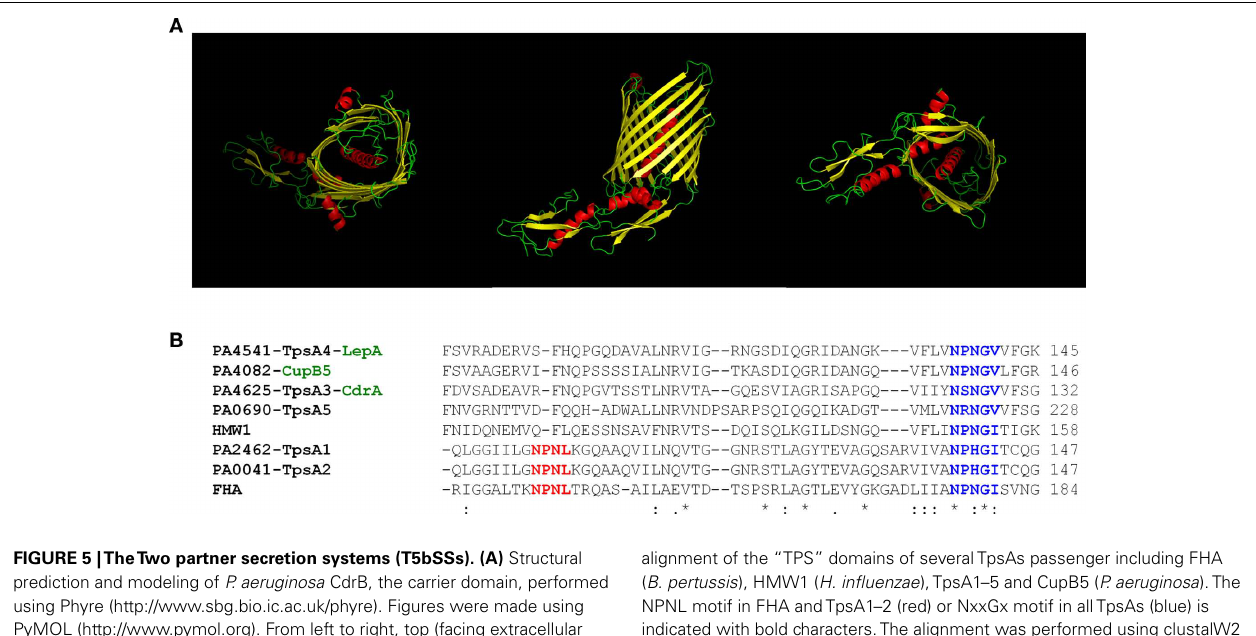
FIGURE 5 |TheTwo partner secretion systems (T5bSSs). (A) Structural prediction and modeling of P. aeruginosa CdrB, the carrier domain, performed using Phyre (http://www.sbg.bio.ic.ac.uk/phyre). Figures were made using PyMOL (http://www.pymol.org). From left to right, top (facing extracellular milieu), side, and bottom (facing periplasm) view. (B) Amino-acid sequence